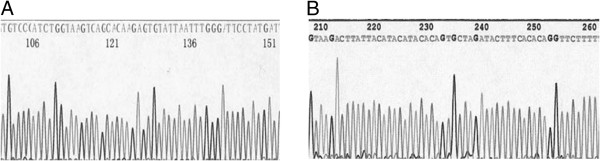
A The partial DNA sequencing results of exon 2 of BRCA1 gene of patient 6. B The partial DNA sequencing results of exon 20 of BRCA1 gene of patient 6.